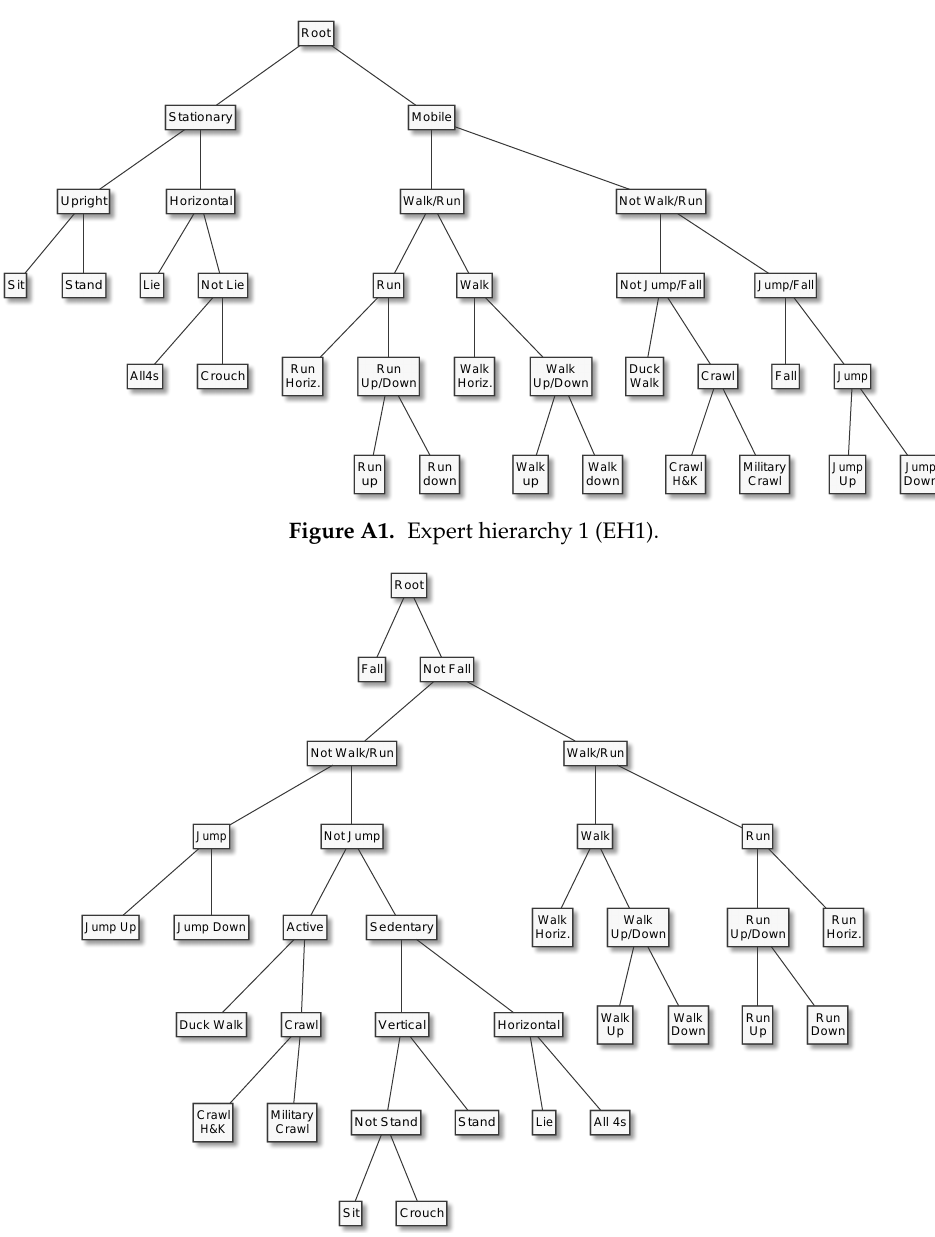
Figure A2. Expert hierarchy 2